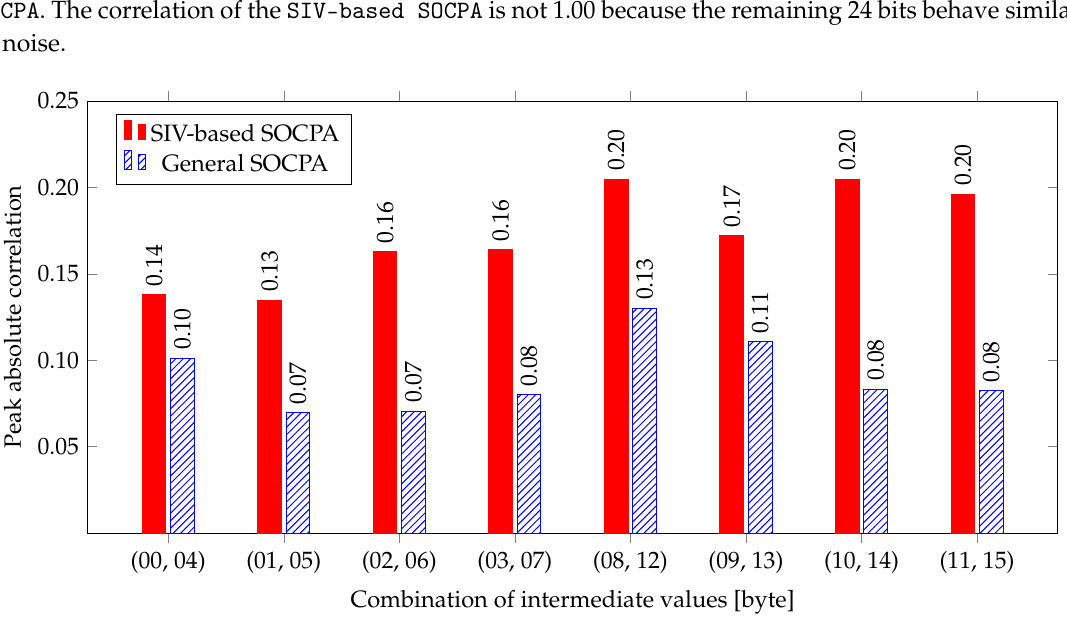
Figure 6. Peak correlation coefficient of the two versions of SOCPA on MixColumns